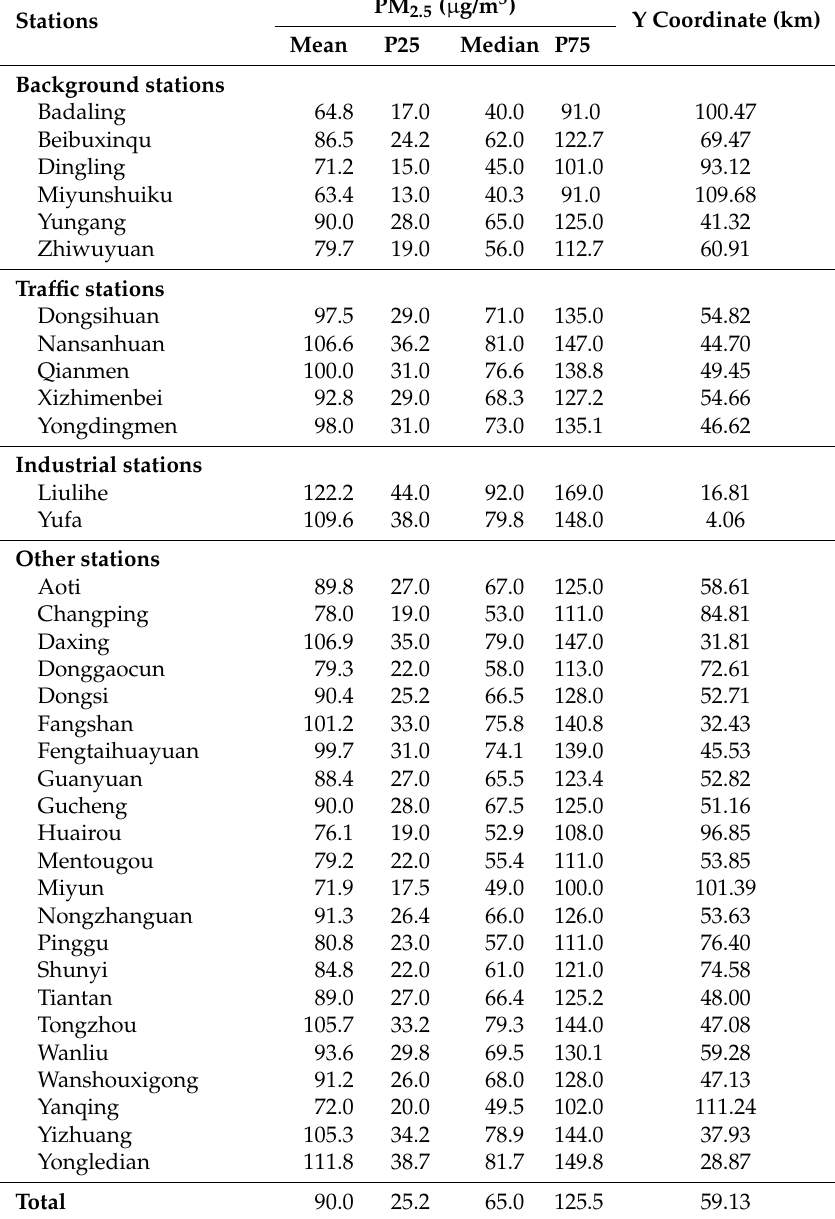
Table 1. PM 2.5 concentrations and Y coordinates of 35 AQM